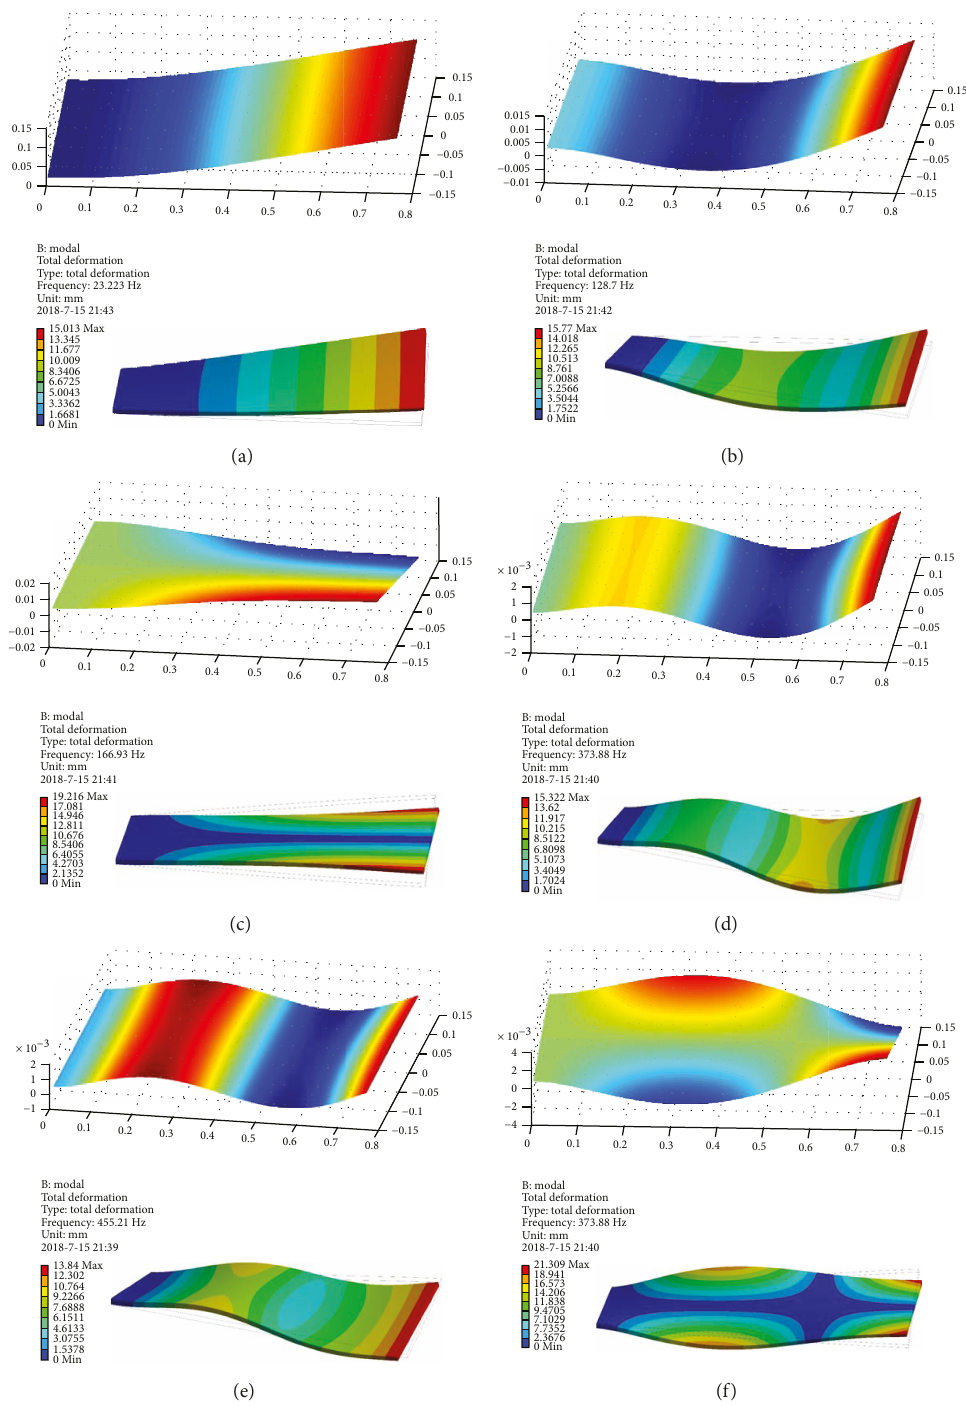
Figure 9: Mode shapes of the FG sandwich blade. (A1) 1st mode shape by Matlab; (B1) 2nd mode shape by Matlab; (C1) 3rd mode shape by Matlab; (D1) 4th mode shape by Matlab; (E1) 5th mode shape by Matlab; (F1) 6th mode shape by Matlab; (A2) 1st mode shape by ANSYS; (B2) 2nd mode shape by ANSYS; (C2) 3rd mode shape by ANSYS; (D2) 4th mode shape by ANSYS; (E2) 5th mode shape by ANSYS; (F2) 6th mode shape by